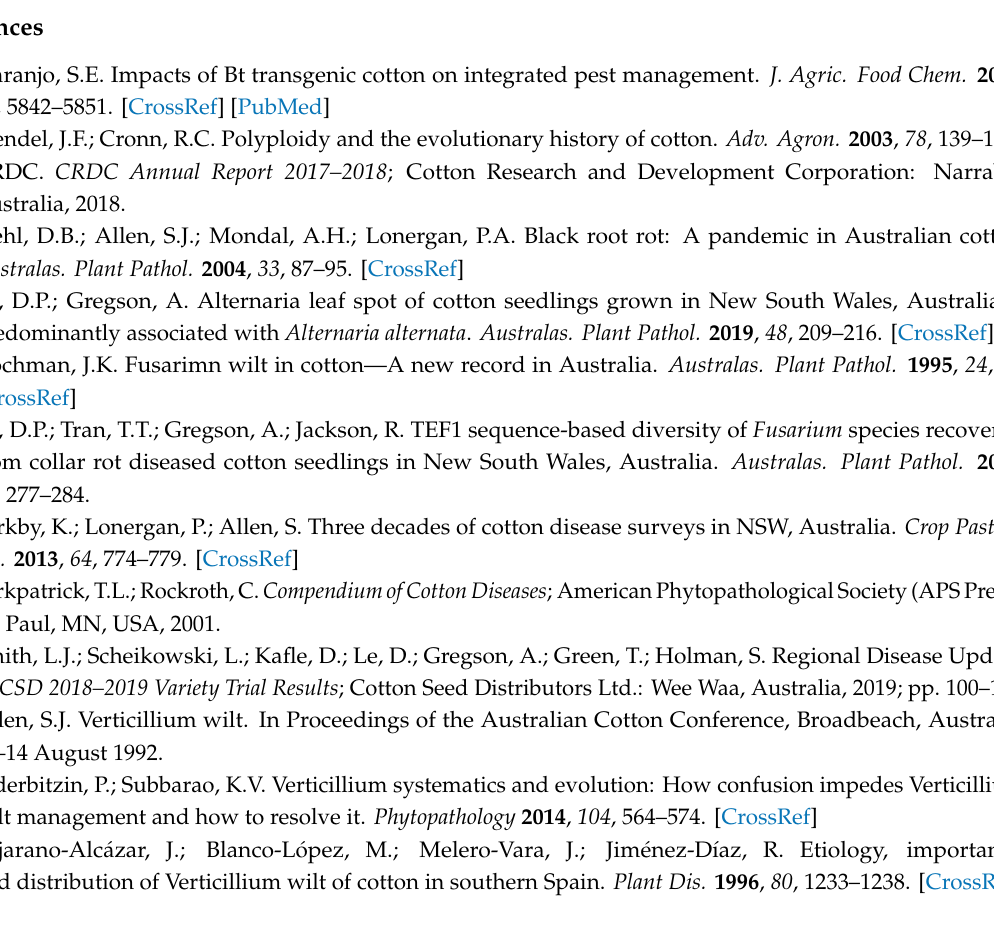
Table S1: Relative number of D and ND pathotypes 1 recovered from the confirmed co-infected cotton plants in pot trial 1 and